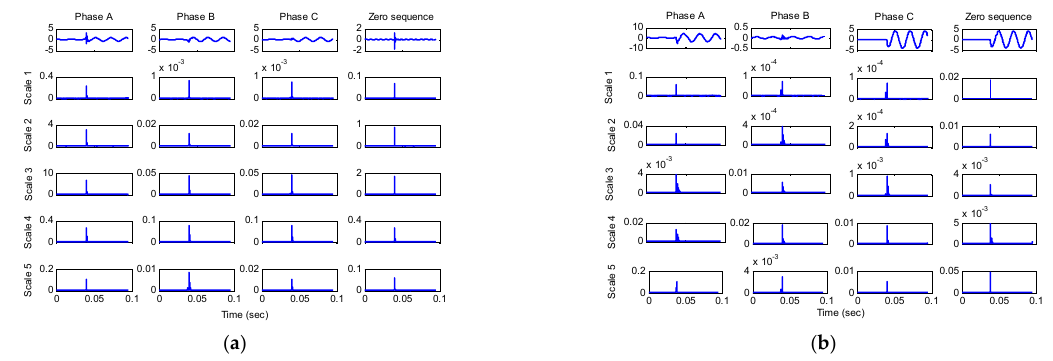
Figure 7. In the event of an external short circuit, DWT of differential currents from scale 1 to scale 5: ( a ) analysis of high-voltage winding faults; ( b ) analysis of low-voltage winding faults.